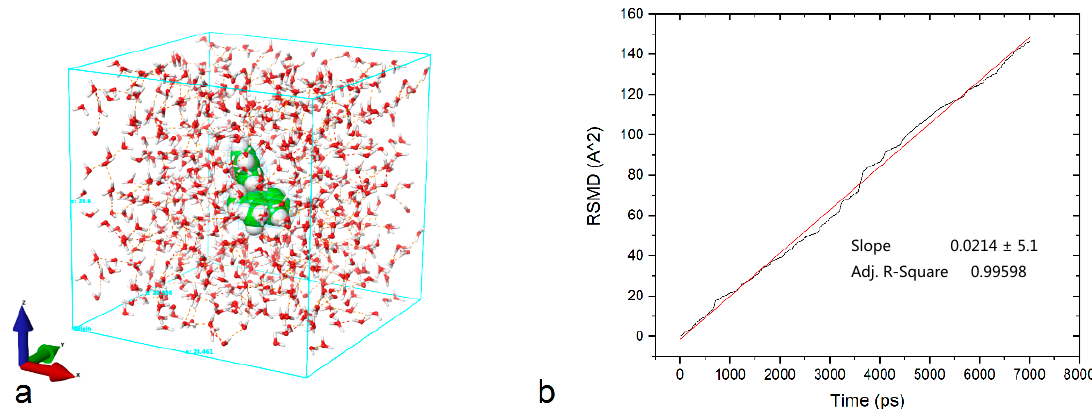
Figure 1. ( a ) The molecular dynamics set-up is shown for simulating the diffusion process of a single molecule of the mefenamic acid in aqueous media; ( b ) the root-mean-squared deviations of the target molecule within 7 ns of simulation time. The slope is the first derivative by time and was used to estimate the diffusion coefficient.